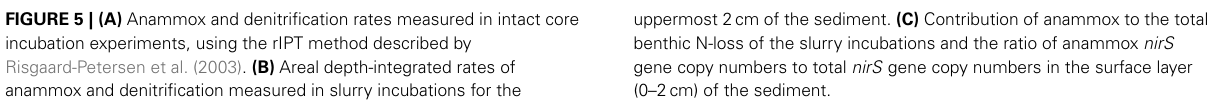
uppermost 2cm of the sediment. (C) Contribution of anammox to the total benthic N-loss of the slurry incubations and the ratio of anammox nirS gene copy numbers to total nirS gene copy numbers in the surface layer (0–2cm) of the